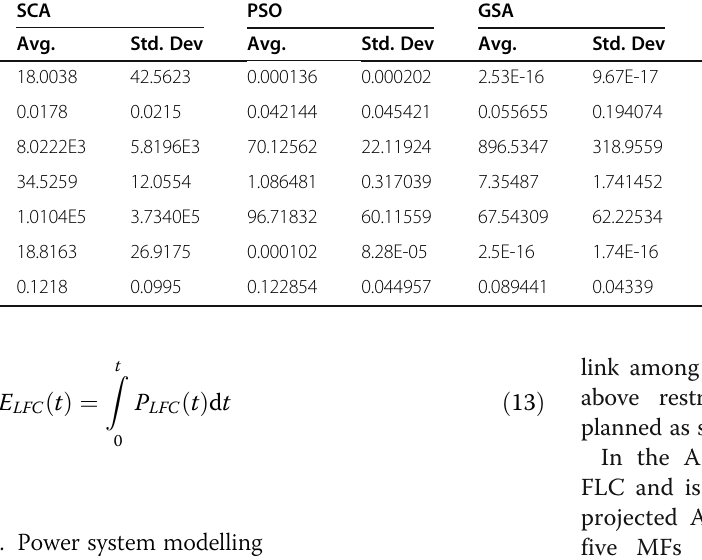
Table 1 Comparison of proposed SGWO with other techniques for unimodal benchmark test functions F SCA PSO